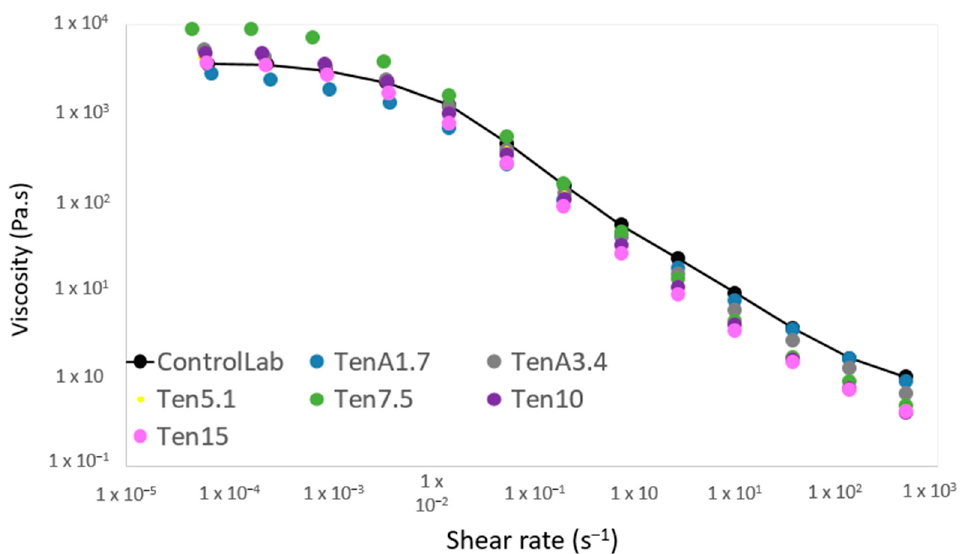
. γ ) of TenA1.7, TenA3.4, Ten5.1,